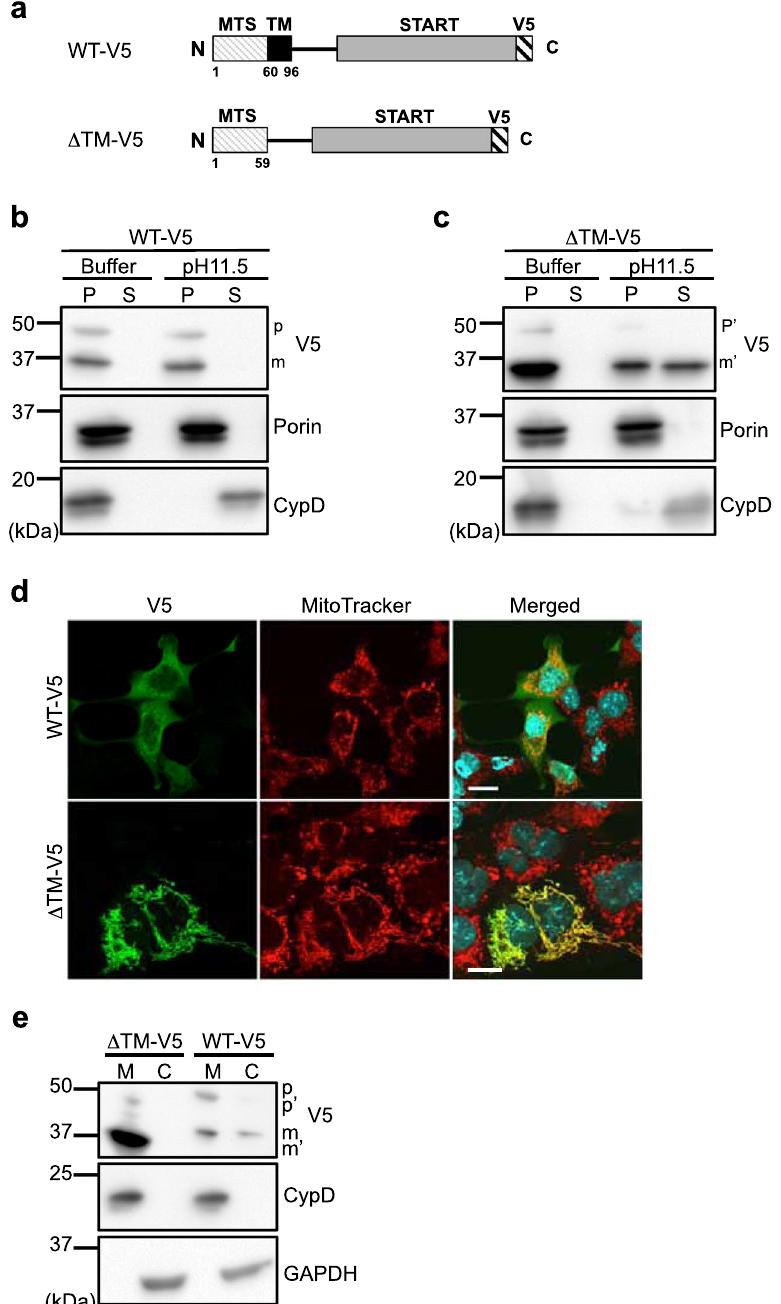
Figure 2. The TM domain of StarD7 is important for the integration of the protein into the mitochondrial membrane in HEPA-1 cells. ( a ) Schematic of WT-V5 and Δ TM-V5. The putative TM domain (Arg 60 -Gln 96 ) was deleted in Δ TM-V5. V5-tags were fused at the C-terminus of both proteins. (b and c) Alkaline extraction assay. Mitochondria isolated from HEPA-1 cells transfected with WT-V5 ( b ) and Δ TM-V5 ( c ) were treated with isotonic buffer (Buffer) or alkaline buffer (pH 11.5). After centrifugation, the pellet (P) and supernatant (S) were dissolved in the same volume of sample buffer, and the same volume of protein solutions were analyzed by Western blotting using anti-V5, -porin and -CypD antibodies. p (48 kDa) and m (37 kDa), and p’ (45 kDa) and m’ (35 kDa) indicate the precursor and mature forms of WT and Δ TM protein, respectively. Porin is a membrane-integrated protein and CypD is a matrix protein. ( d ) HEPA-1 cells were transfected with the expression vector for WT-V5 or Δ TM-V5, then immunostained with anti-V5 antibody followed by anti-mouse IgG Alexa488 (green) and MitoTracker Red (red). Nuclei were stained with DAPI (blue). Bars indicate 10 μ m. ( e ) Mitochondria and cytosol were separated from cells transfected with WT-V5 or Δ TM-V5 by subcellular fractionation. Proteins were analyzed by Western blotting using anti-V5, -CypD and -GAPDH antibodies. M and C indicate mitochondria and cytosol,